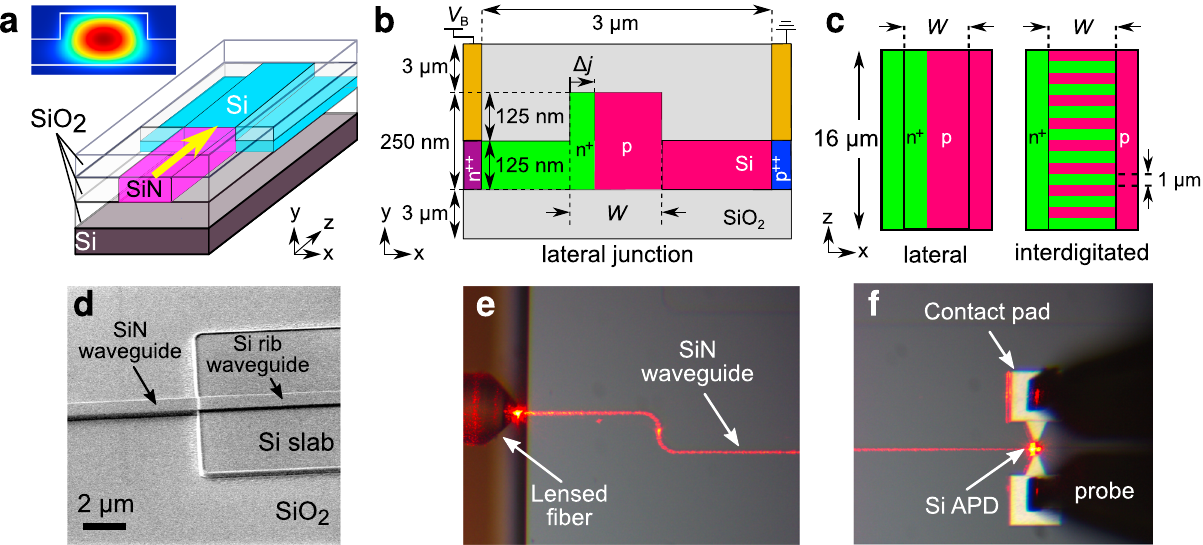
Fig. 1 Device structure and doping con fi gurations. a Schematic of the APD device, consisting of a Si rib waveguide end- fi re coupled to an input SiN waveguide. The yellow arrow denotes the propagation direction of input light. The inset shows the simulated optical mode in the Si rib waveguide. b Cross- sectional view of the Si rib waveguide with a lateral doping pro fi le. The junction placed at a distance Δ j from the left edge of the waveguide core with a width W . A reverse bias voltage V B is applied via metal contacts deposited on top of heavily doped p ++ and n ++ regions. c Top view of the Si rib waveguide, showing the lateral and interdigitated doping pro fi les. a – c are not drawn to scale. d Scanning electron microscope (SEM) image of a fabricated device without the top SiO 2 cladding and metal contacts. e , f Fabricated devices imaged under an optical microscope, showing the lensed fi ber coupling and Si APD regions, respectively. The red glow is due to the scattering of the 685-nm input